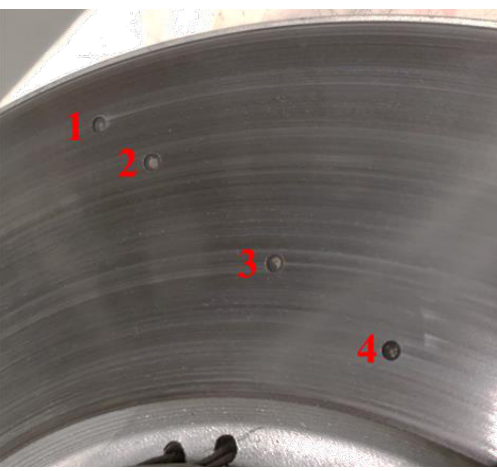
Figure 1. Position of thermocouples 1–4 on the outboard side of the